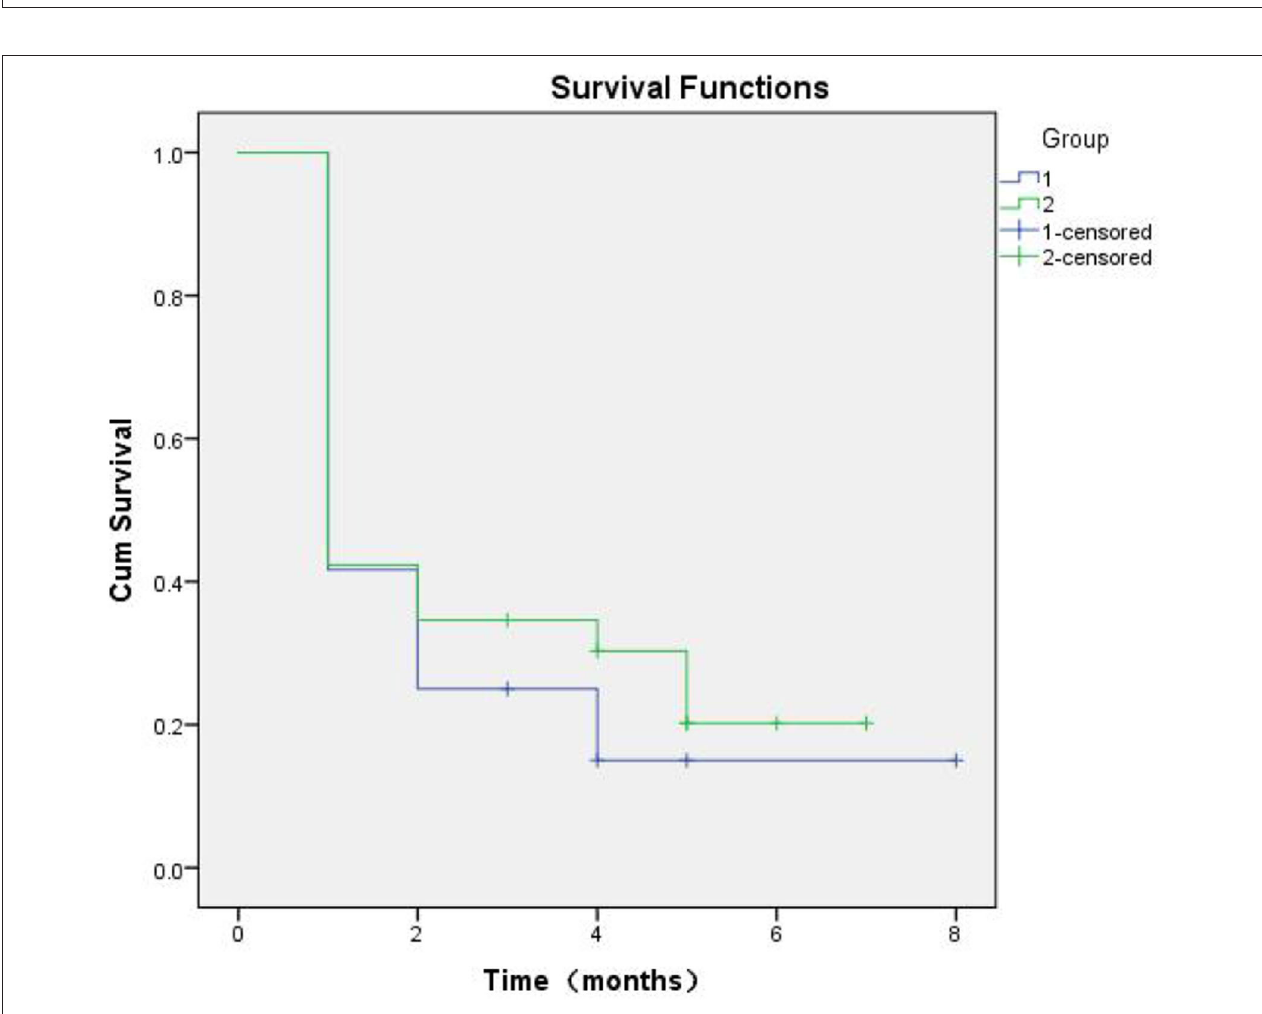
FIGURE 6 | Kaplan-Meier curves based on SERPINA3 levels in patients with alcohol dependence during follow-up of up to 8 months ( P = 0.489).